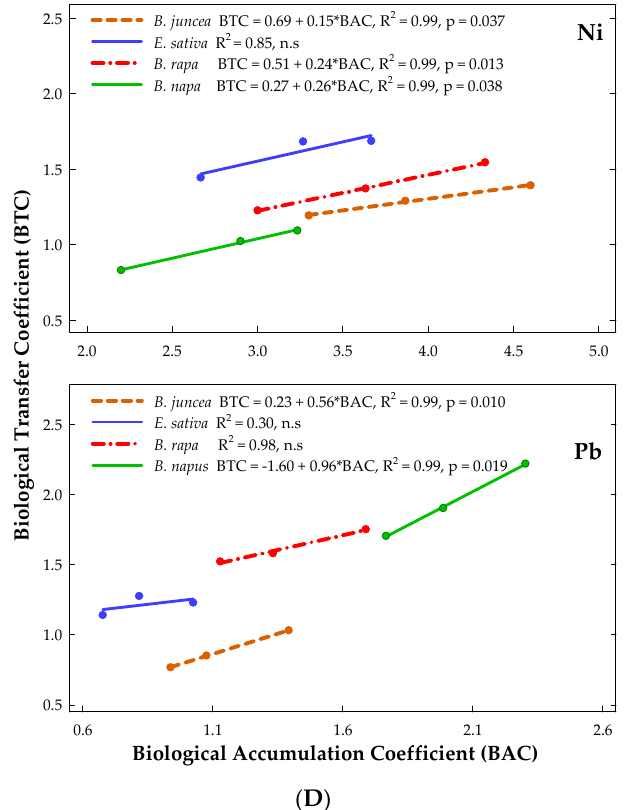
Figure 2. Relationships between biological accumulation coefficient (BAC) and biological transfer coefficient (BTC) of test crops for Zn and Cu ( A ), Fe and Mn ( B ), Cd and Cr ( C ), and Ni and Pb ( D ) concentrations (mg kg − 1 dry weight). Relationship is significant at p < 0.05. n.s represents non-significant ( p > 0.05).